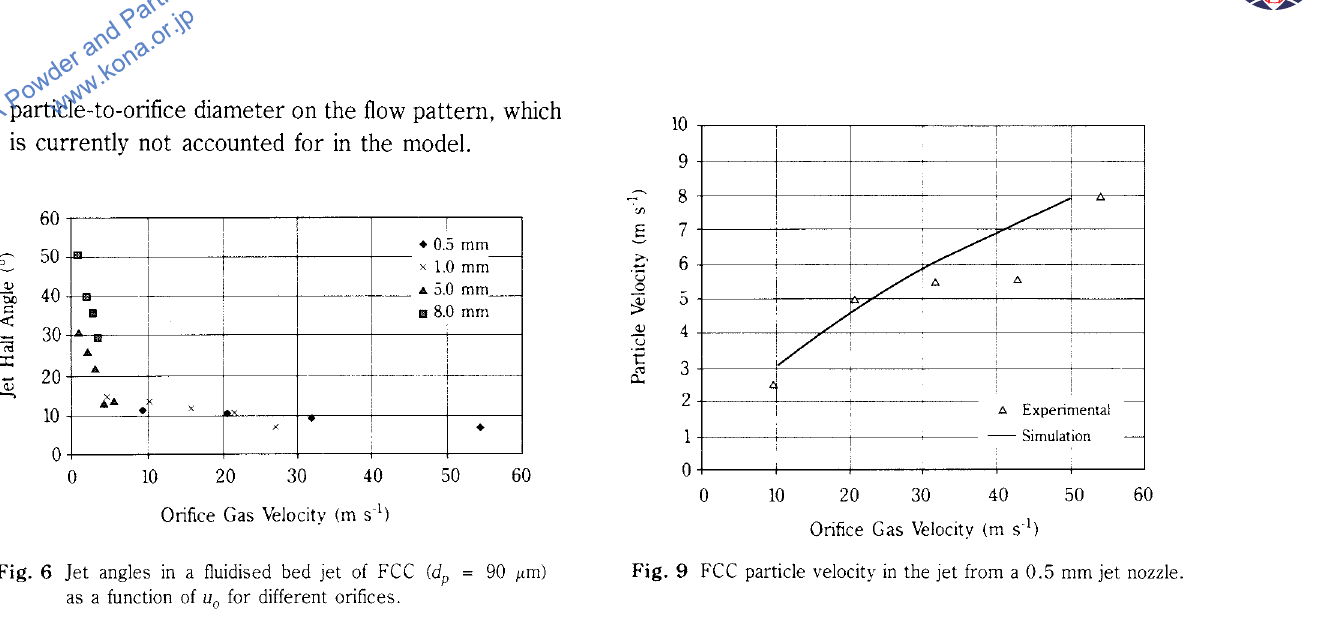
Fig. 6 Jet angles in a fluidised bed jet of FCC (dP as a function of u for different orifices. 0